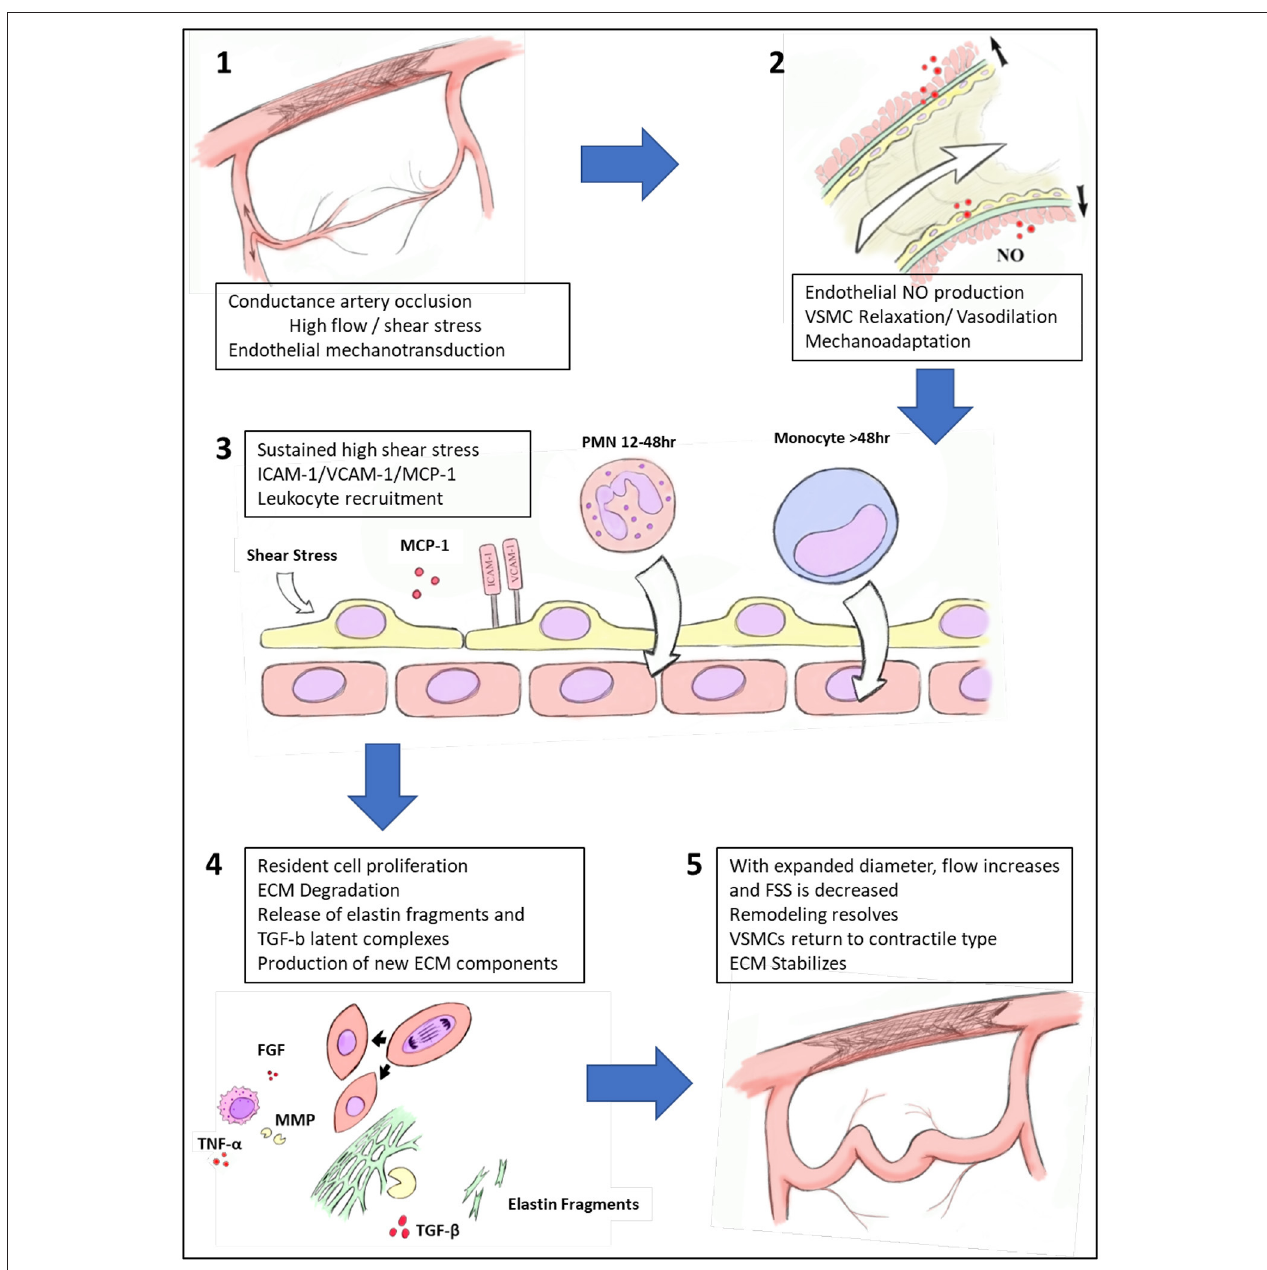
FIGURE 3 | Process of collateral artery recruitment and remodeling. Following occlusion of a conductance vessel, there is immediate increase in flow across pre-existing collaterals. The resulting elevated fluid shear stress (FSS) is recognized by endothelial cells via mechanoreceptors, which leads to nitric oxide (NO) production and subsequent relaxation of vascular smooth muscle cells (VSMCs) and then vasodilation. Prolonged vasodilation produces mechanoadaptation of collaterals. With sustained elevation of FSS, endothelial cells are activated to express intercellular adhesion molecule 1 (ICAM-1), vascular cell adhesion molecule 1 (VCAM-1) and monocyte chemoattractant protein-1 (MCP1) which recruit inflammatory cells to the developing collateral artery. With the aid of a population of perivascular macrophages, growth factors and cytokines such as tumor necrosis factor-alpha (TNF- α ), fibroblast growth factor (FGF) are produced, increasing phenotypic modification of VSMCs and proliferation. Elastolytic enzymes such as matrix metalloproteinases (MMPs) are produced, which partially degrade the elastic framework, releasing latent transforming growth factor-beta (TGF- β ) complexes. As diameter expands, FSS decreases and the pressure for outward remodeling dissipates. VSMCs return to differentiated phenotype and collateral artery extracellular matrix (ECM)